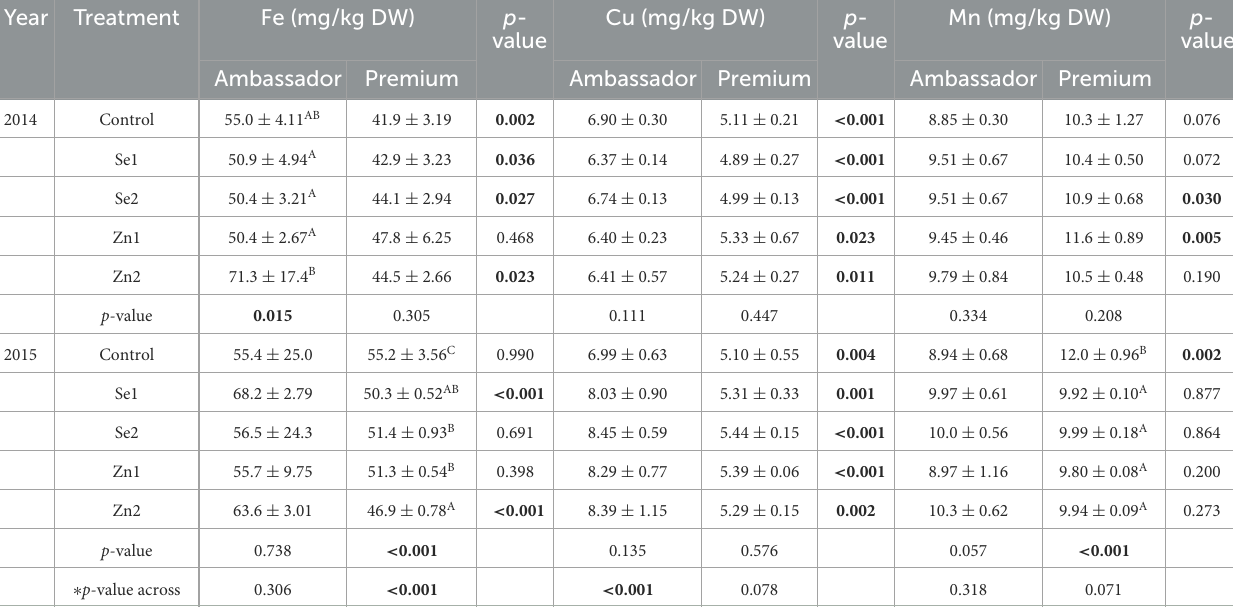
TABLE 2 Effect of foliar application of Se and Zn, depending on variety and year, on seed Fe, Cu, and Mn